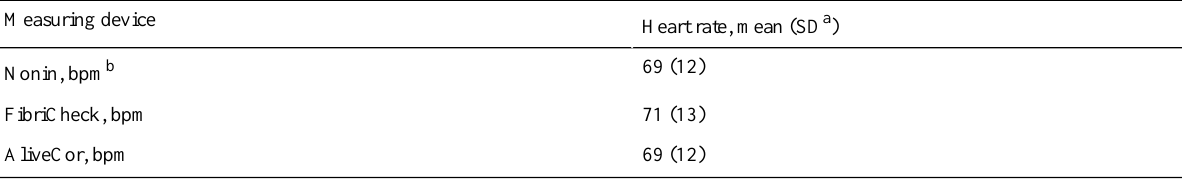
Heart rate, mean (SD a )Measuring